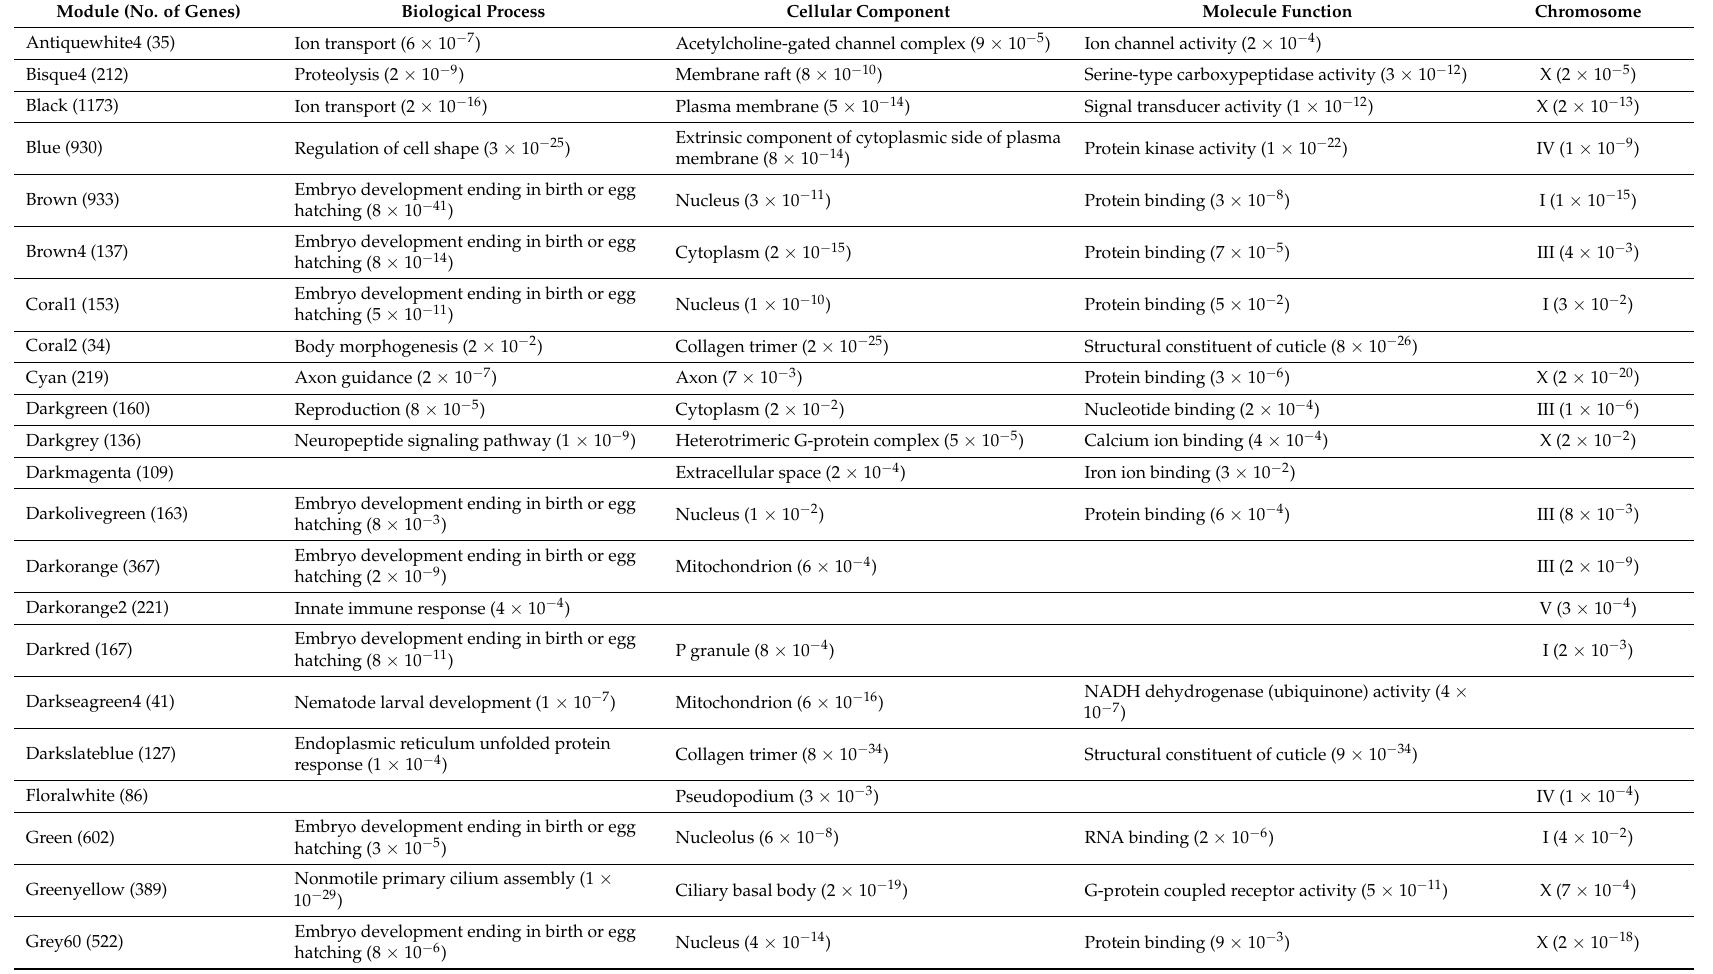
Table 1. Gene ontology (GO) and chromosome annotation of the identified 48 gene co-expression modules in C. elegans . Module (No. of